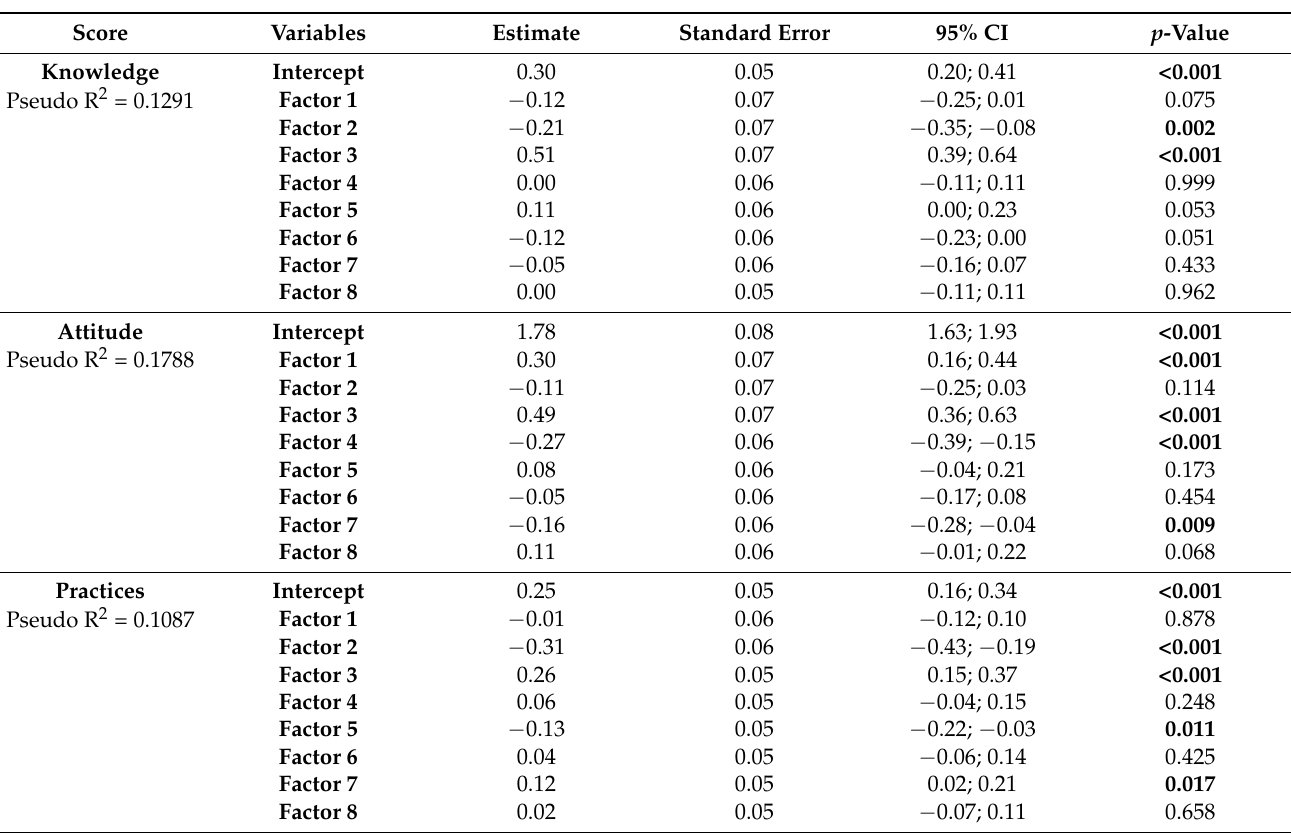
Table 5. Multiple associations of the scores of knowledge, attitudes and practices with the factors that influence the KAP of the residents from Feira Grande, Alagoas, Brazil in